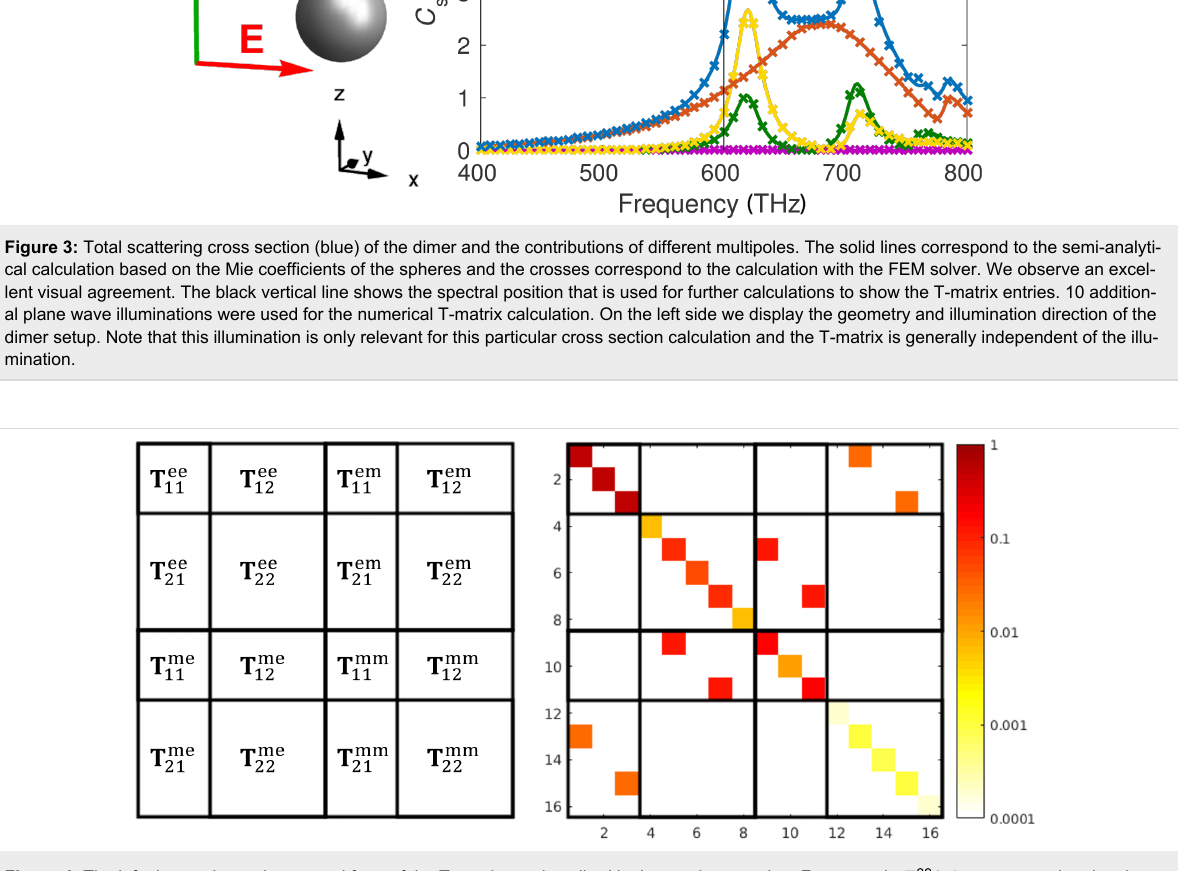
Figure 4: The left picture shows the general form of the T-matrix, as described in the previous section. For example represents the electric dipole coupling. In the following we always present the T-matrix in this way. On the right hand side we see the absolute values of the T-matrix entries for the dimer on a logarithmic scale at 600 THz. This matrix was calculated semi-analytically with the Mie coefficients of the single spheres. The numbers on the axis count the rows and columns,